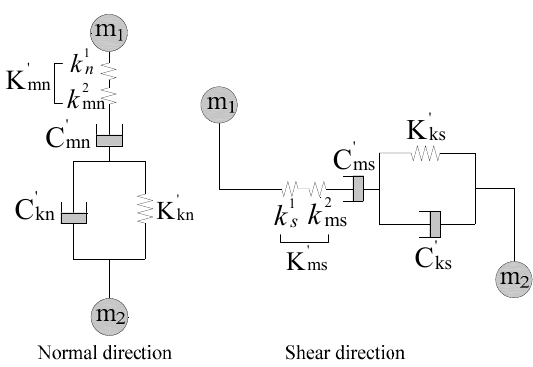
Figure 8. Equivalent meso Burger’s model for contacts between aggregates and asphalt mastic.